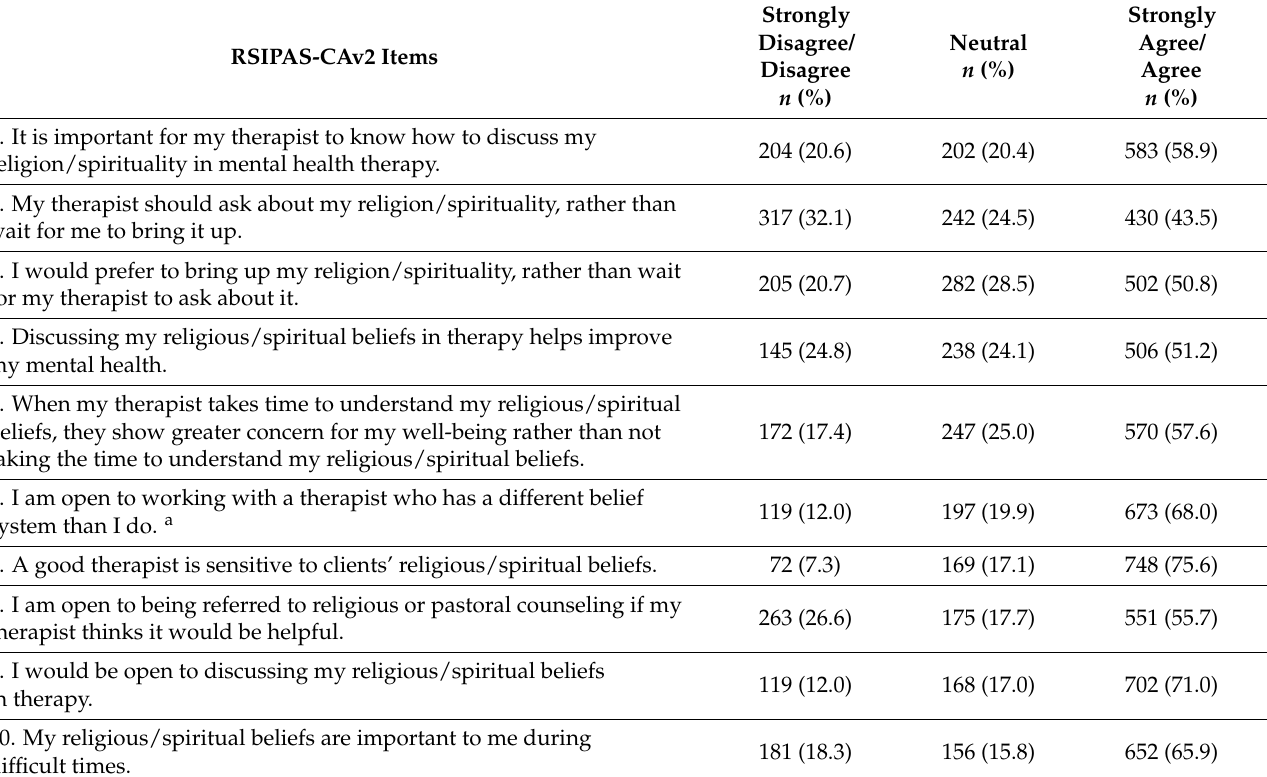
Table 3. Frequencies of Responses to Religious/Spiritually Integrated Practice Assessment Scale-Client Attitudes v2 (RSIPAS-CAv2) items ( n =